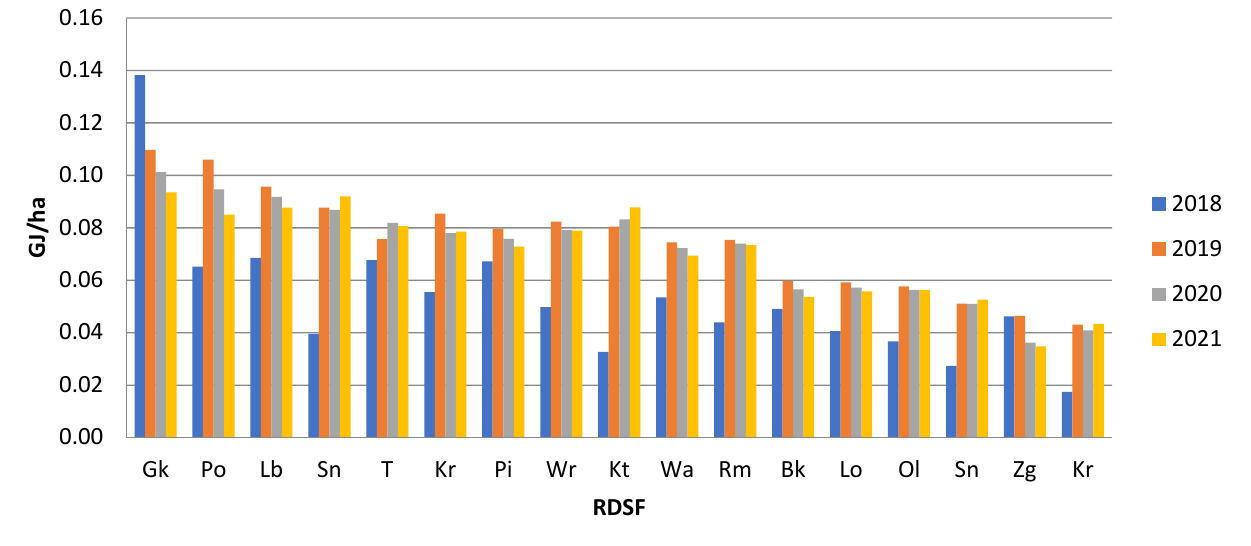
Figure 4. Biomass energy potential in relation to the forest area in separate areas of Poland per ha (for a biomass moisture content of 30%). Own elaboration based on the available data.